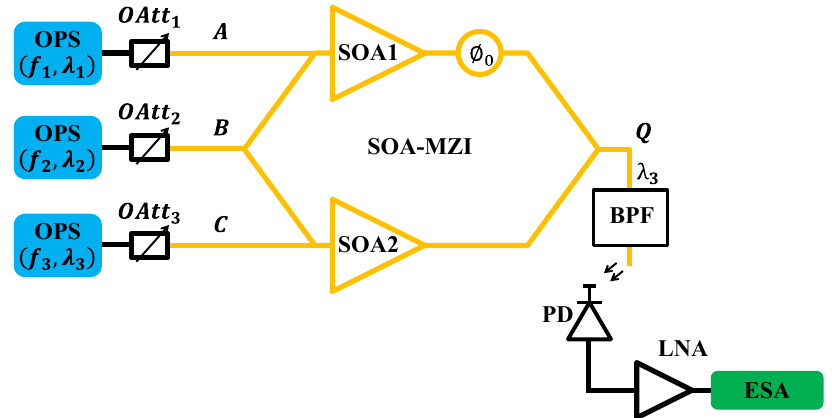
Figure 5. All–optical “AND” gate setup dependent on the SOA-MZI using a differential modulation architecture for the experimental and simulation studies.